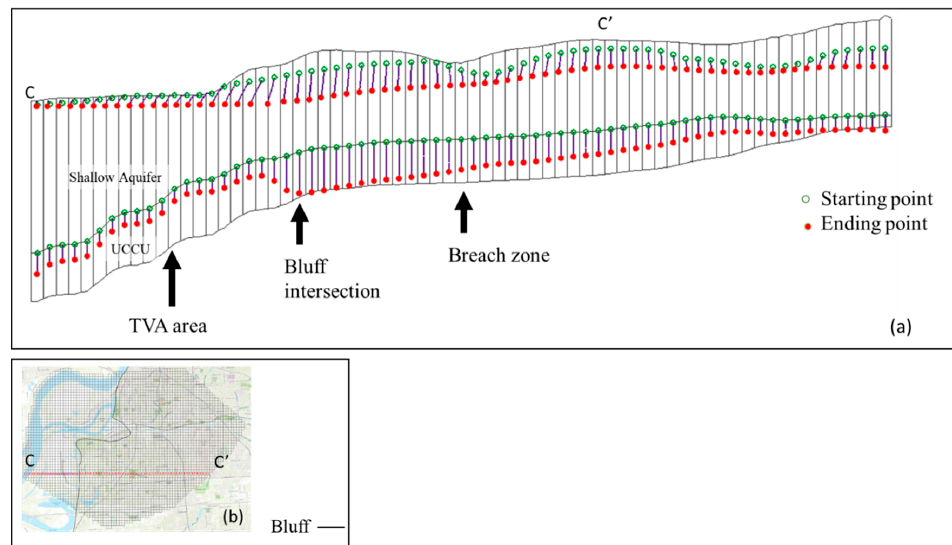
Figure 14. C–C’ cross section of the shallow aquifer and the UCCU, showing particle tracking results. ( a ) shows cross-section of the shallow aquifer and the UCCU along C–C’. ( b ) shows the plan view of the cross section. Particles are placed on top of the groundwater in the shallow aquifer and top of the UCCU in the year of 2005 (green mark). Forward particle tracking shows the transport of the particles in the layers (blue line), and the position of each particle at the end of simulation in 2015 (red